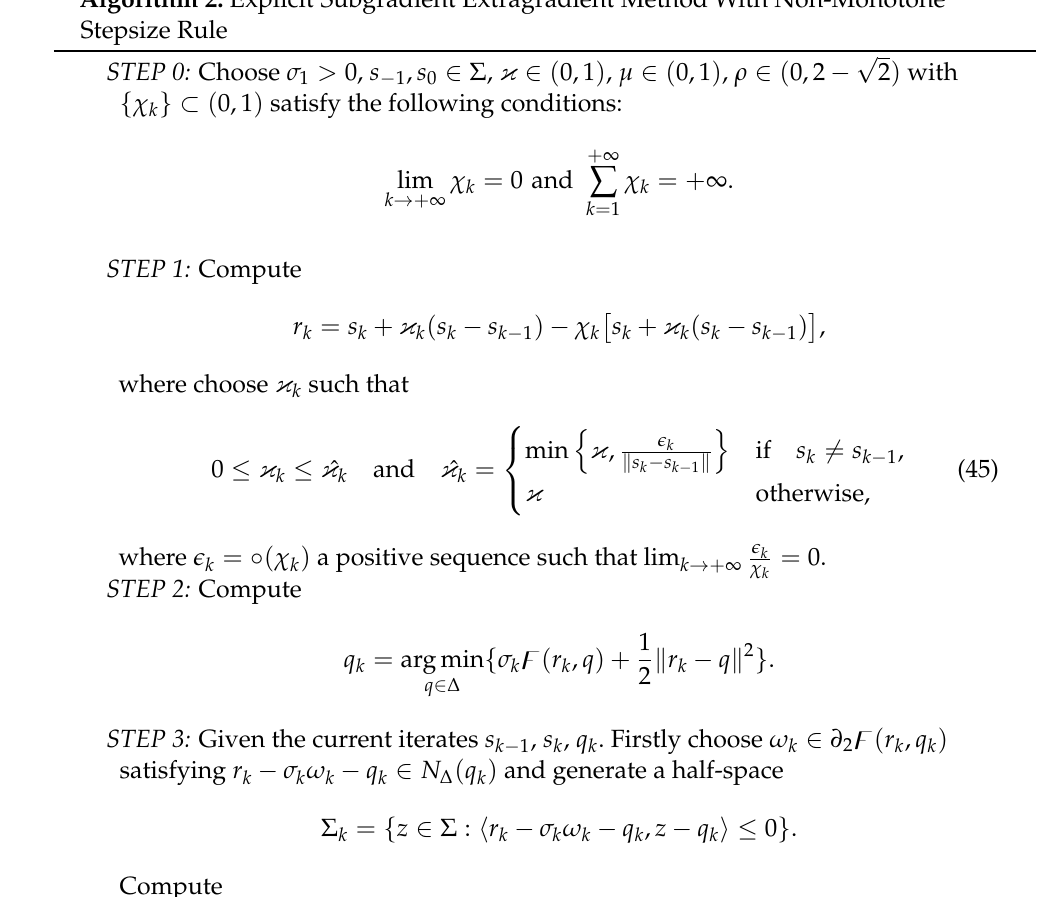
Algorithm 2: Explicit Subgradient Extragradient Method With